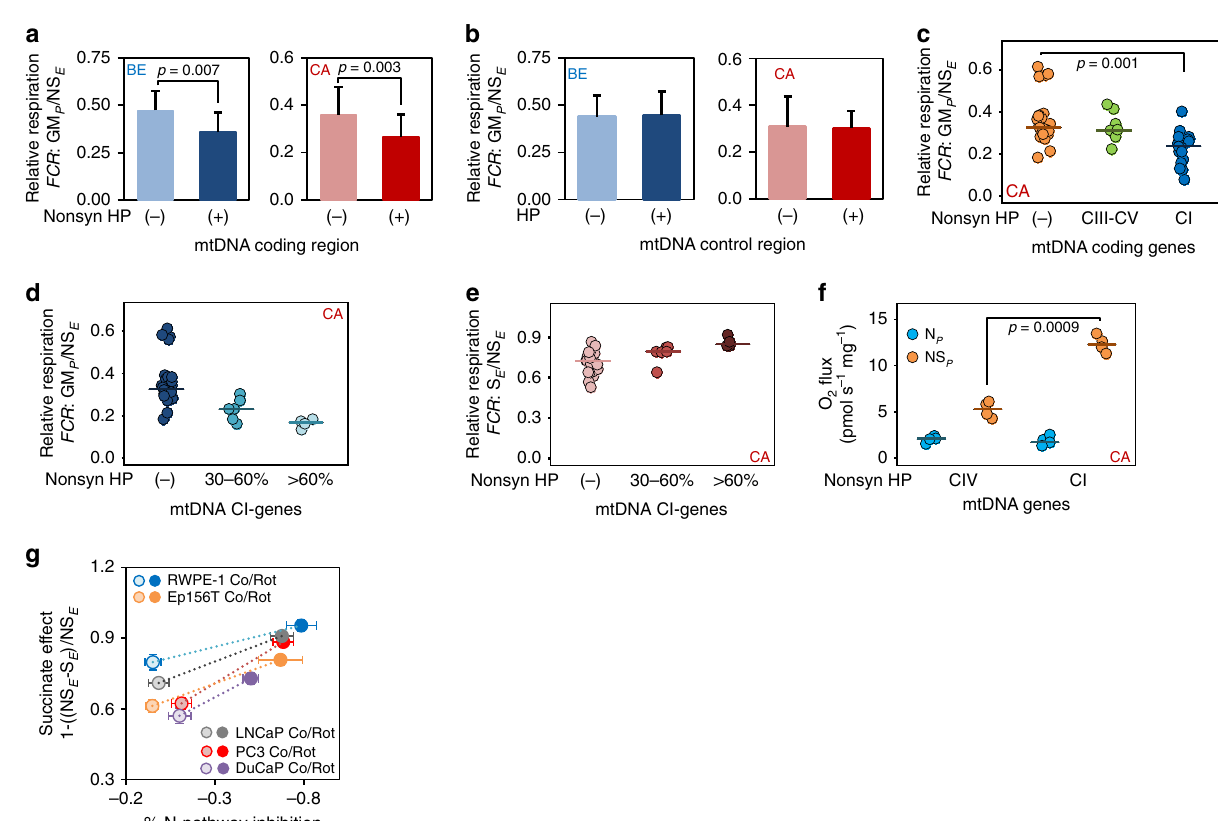
Fig. 4 mtDNA heteroplasmies and respiratory capacities. a Relative GM-OXPHOS respiratory capacity with glutamate&malate (GM P /NS E ) in benign (blue) or malignant (red) samples carrying either no or only synonymous HPs ( − ) ( N BE = 36 and N CA = 23) versus samples carrying non-synonymous HPs ( + ) ( N BE = 14 and N CA = 27) in the coding regions of the mt-genome. Values present mean ± SD. Differences in mean values were tested for signi fi cance using Wilcoxon rank-sum test. b Comparison of relative GM-OXPHOS capacity in samples without mutations ( − ) ( N BE = 38 and N CA = 37) versus samples with mutations ( + ) ( N BE = 12 and N CA = 13) within the non-coding (control) region of the mt-genome. Values represent mean ± SD. c Impact of location of non-synonymous HPs on relative GM-OXPHOS capacities. Tumor tissue samples were categorized according to no HPs ( − ) (orange; N = 24), and HPs located in genes encoding proteins of CIII – CV (CO, ATP, CYB; green; N = 10) or in genes encoding proteins of CI (ND1 – ND5; blue; N = 20). d – e Relative GM-OXPHOS (GM P /NS E , d ) and relative S-ET (S E /NS E , e ) respiratory capacities in malignant tissue samples harboring non-synonymous HPs in CI-coding mt-genes. Tumors were grouped into samples carrying no non-synonymous HPs (( − ); N = 23), samples with variant levels of 30 – 60% (30 – 60%; N = 6) and samples with variant levels >60% (>60%; N = 4). Differences in mean values were tested for signi fi cance using one-way ANOVA followed by Tukey ’ s HSD test. f N-pathway (blue) and S-pathway (orange) respiratory capacities in malignant samples harboring high-level (>60%) non- synonymous HPs in either CIV-coding genes ( N = 4) or CI-coding genes ( N = 4). Differences of in mean values were tested for signi fi cance using Wilcoxon rank-sum test. Values presented in c-f represent mean values and individual data points. g S-pathway OXPHOS capacity upregulation by partial inhibition of N-pathway oxidative fl ux in benign (RWPE1, N = 3; EP156T, N = 3) and malignant (PC3, N = 6; LNCaP, N = 4; DuCaP, N = 3, N represents number of biologically independent experiments) prostate cell lines. Relative S-pathway OXPHOS capacity (normalized to total respiratory capacity, NS E ) with different degrees of N-pathway inhibition is shown for the fi ve cell lines. Values represent mean ± SD. Source data are provided as a Source Data fi